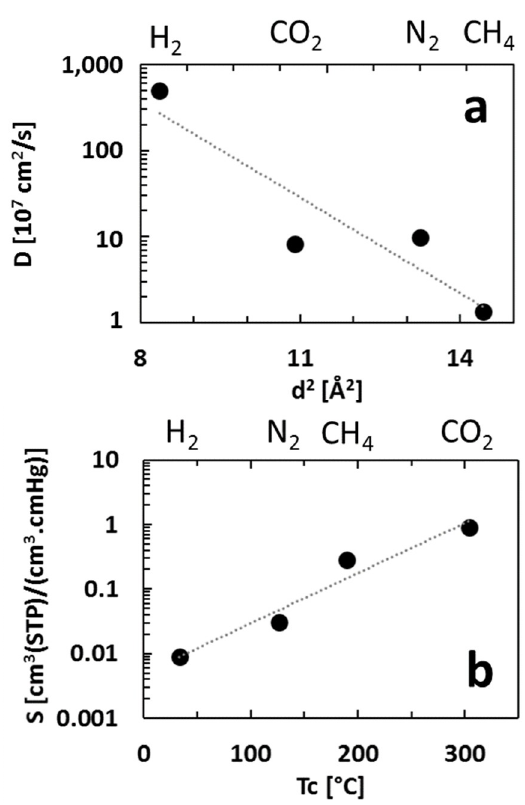
Figure 5. Diffusivity ( a ) and solubility ( b ) coefficients of PIM-EA(H 2 )-TB for H 2 , CO 2 , CH 4 and N 2 at 30 °C and 1 bar.